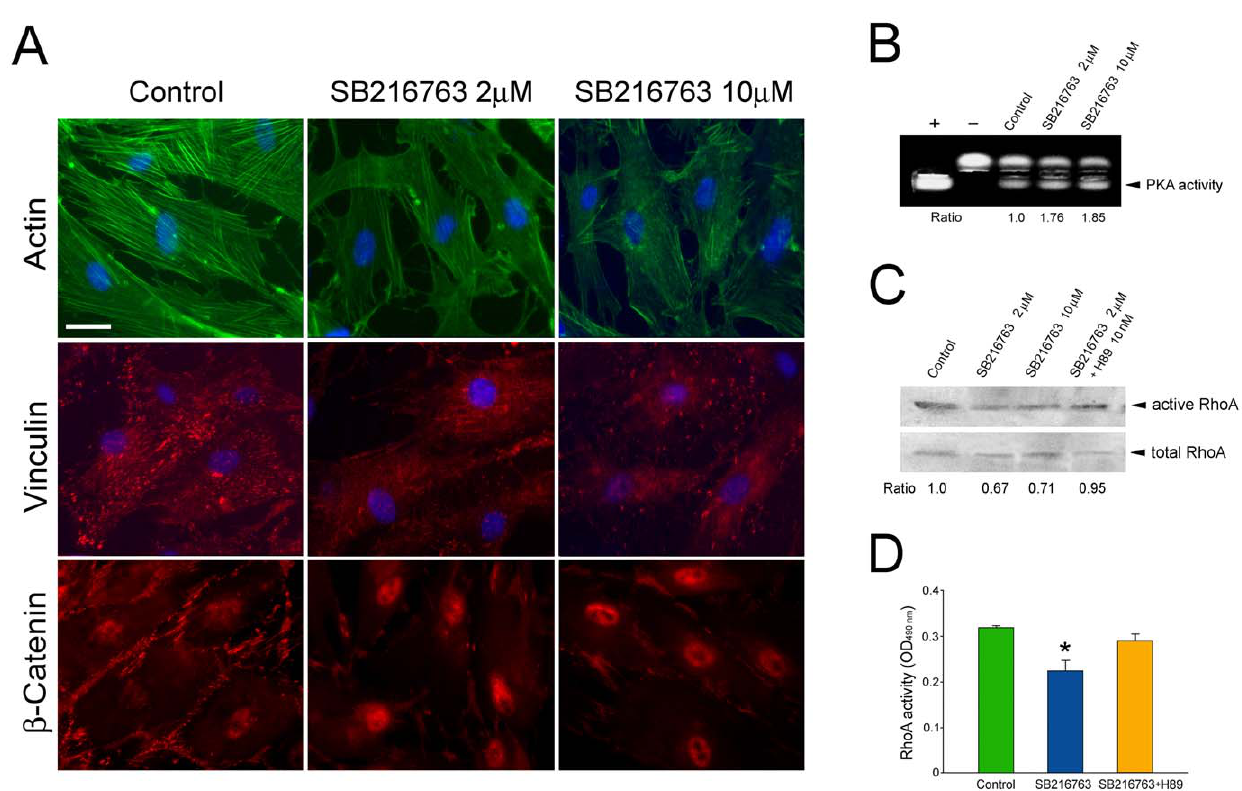
Figure 2. A. Actin (green), vinculin (red), and b -catenin (red) staining in normal human TM cells without (control) or with overnight treatment with 2 and 10 m M SB216763. Bar, 20 m m. B . PKA activity in TM cells without (control) or with treatment with SB216763. Equal amounts of protein lysates were subjected to PKA assays. Positive ( + ) and negative (-) controls were included. The non-phosphorylated (upper band) and the phosphorylated (lower band, arrowhead) substrates were resolved on agarose gels. The PKA activity, judged by the level of the phosphorylated substrate, in 2 (1.76 6 0.14, mean 6 SD, n=3) and 10 (1.85 6 0.15, n=3) m M SB216763 treated cells (P , 0.006 compared to control) was determined by densitometric analyses and normalized to that in untreated controls. C . RhoA activity in TM cells treated with 2 and 10 m M SB216763 or 2 m M SB216763 plus 10 nM H89, a PKA inhibitor. Cells untreated served as control. Active RhoA, measured by pull down assays, was normalized to total RhoA. The level of active RhoA was reduced by approximately 30% by treatment of SB216763. Its level however returned to normal when H89 was included in the treatment. D . RhoA activity as measured by G-LISA. The activity was lower in TM cells treated with 10 m M SB216763 (0.227 6 0.022 vs. 0.318 6 0.004 in control, mean 6 SEM, n=3). H89 treatment elevated the RhoA back to the control range (0.293 6 0.016, n=3). *, P , 0.001 compared to untreated control.